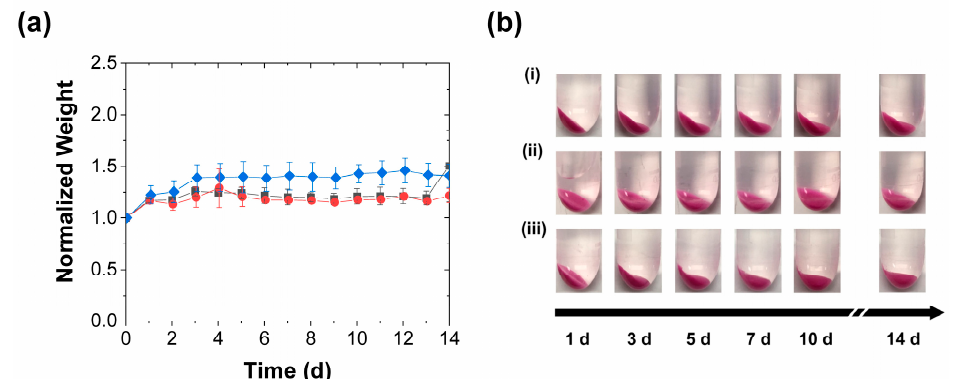
Figure 6. Coacervate swelling in 1 × PBS with ( (cid:4) ) daily perforation with five needle jabs, ( • ) daily compression, and ( (cid:7) ) without mechanical stimulation and characterized by ( a ) gravimetric analysis of the evolutions in normalized weights (mean ± SD) and ( b ) digital photography ( i ) without mechanical stimulation, ( ii ) with periodic perforation, and ( iii ) with periodic compression. All coacervate weights are normalized to their initial values at the start of the release experiment. The lines are guides to the eye.